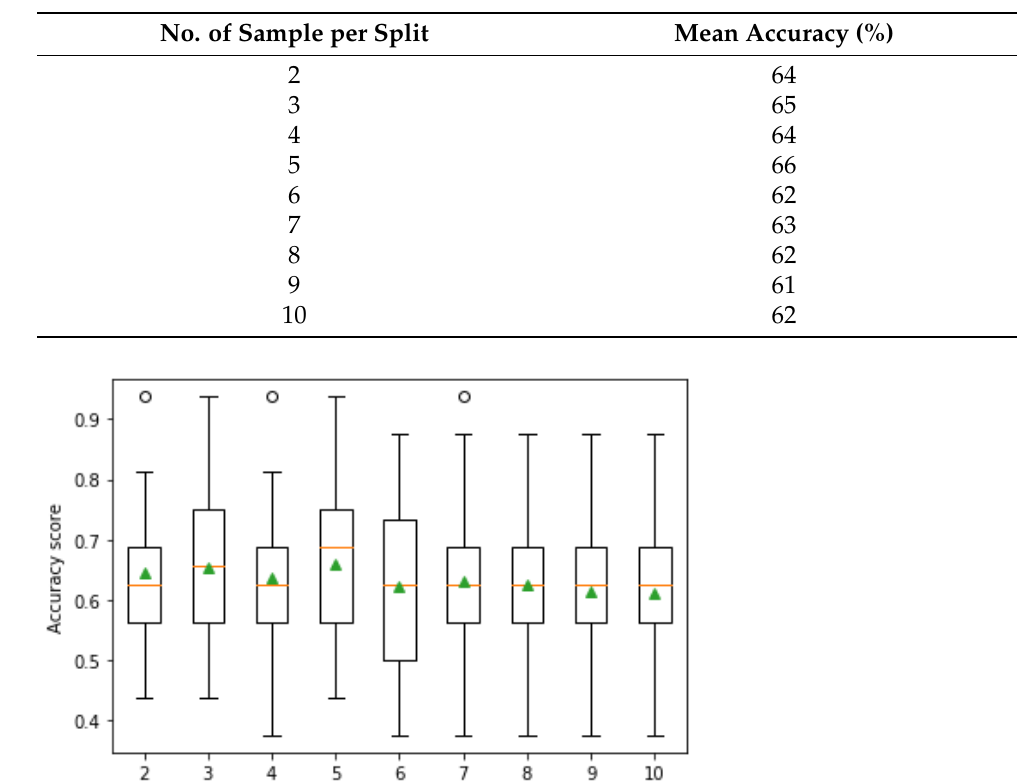
Table 8. Haiti: Predictive accuracy score against number of samples per split.